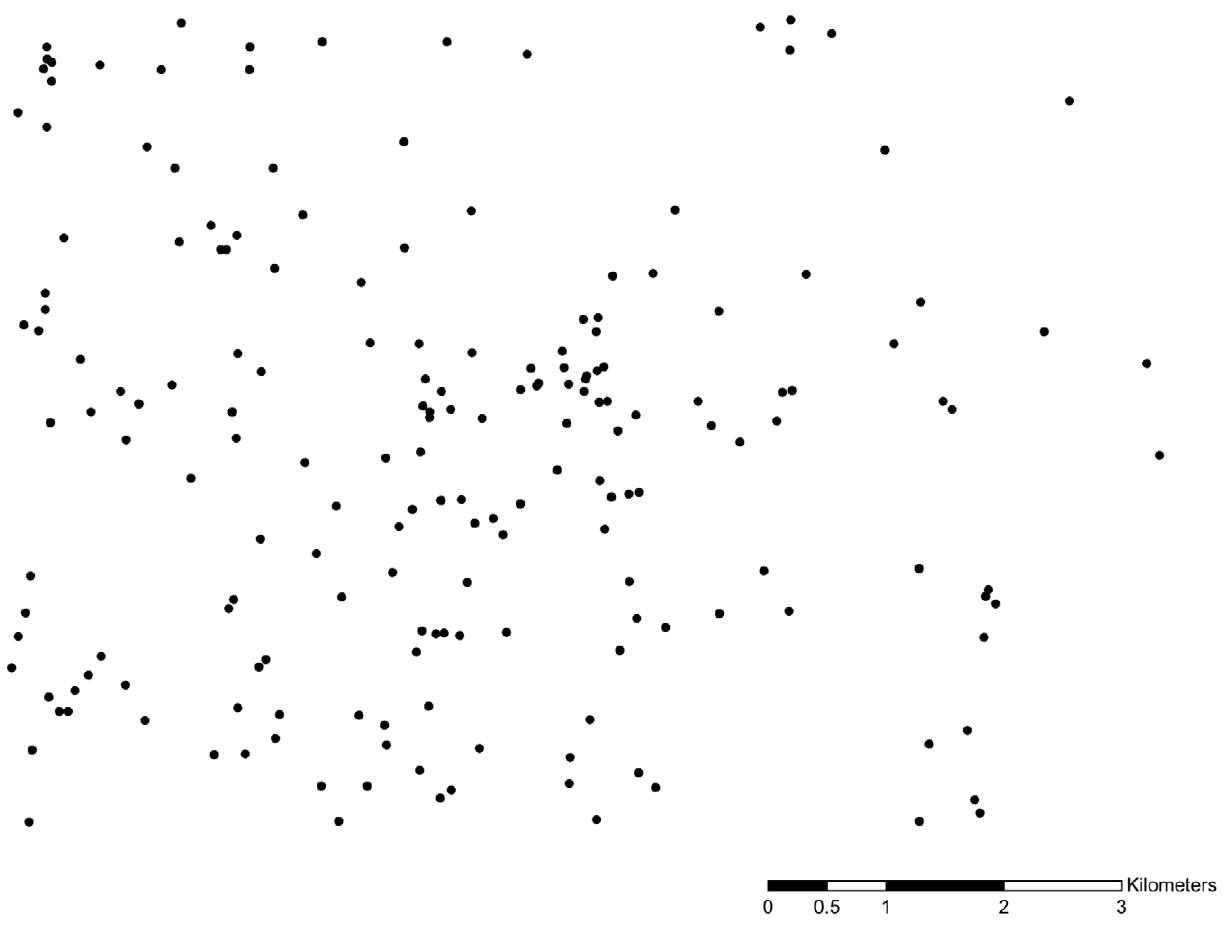
Figure 3. Sample of burglary events occurring in Mesa, Arizona during 2008 employed in the analysis. Additional geographic identifiers have been omitted from the map to preserve privacy.